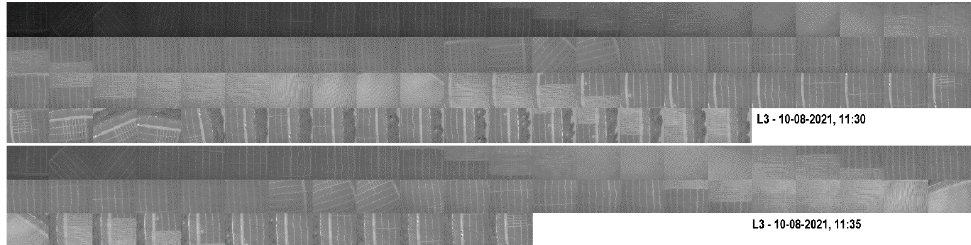
Figure 6. Two sets of thermal images arranged according to the order of registration for location L3 (rape field). The graphs of the statistical parameters marked with the letters G and H correspond to them in Figure 7. The same contrast table was set up for both sets using the linear method, using the minimum and maximum DN values of the entire set.